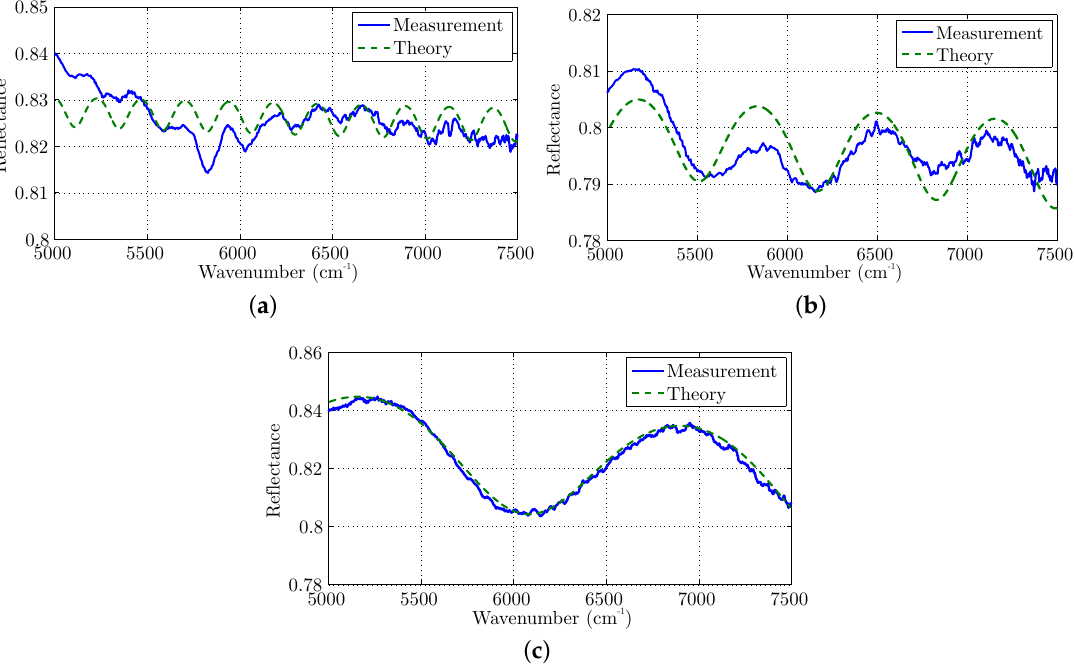
Figure 9. Application of the transmission line model to coated metallic samples, to extract thickness ( a ) 17.5 µ m, ( b ) 6.8 µ m and ( c ) 2.41 µ